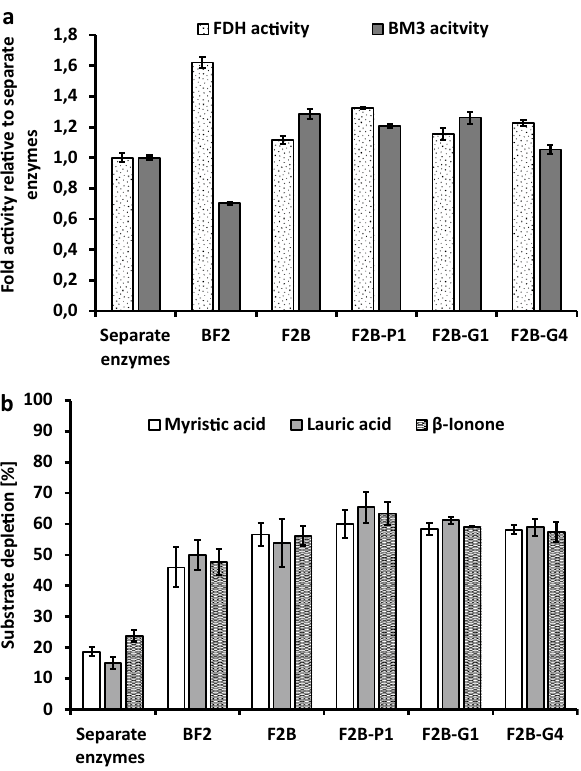
Figure 2. Substrate conversion by individual BM3 4m and FDH2 and their fusions. ( a ) P450 (50 nM) activity measured with 12- p NCA (0.2 mM, dissolved in DMSO at 2% (v/v)), NADPH (1 mM) in potassium phosphate buffer (KPi, 50 mM pH 8.1). FDH (100 nM) activity measured with sodium formate (0.6 M), NADP + (0.5 mM) in KPi (50 mM, pH 7.5). ( b ) Conversions of myristic acid, lauric acid and β-ionone (0.2 mM) by P450 with concomitant NADPH regeneration via FDH-catalyzed formate oxidation: individual and fused enzymes (50 nM), NADP + (0.63 mM for fatty acids, 1 mM for β-ionone), sodium formate (1.5 M) in KPi buffer (50 mM, pH 7.5). The displayed values are means of triplicate measurements with standard deviation as error